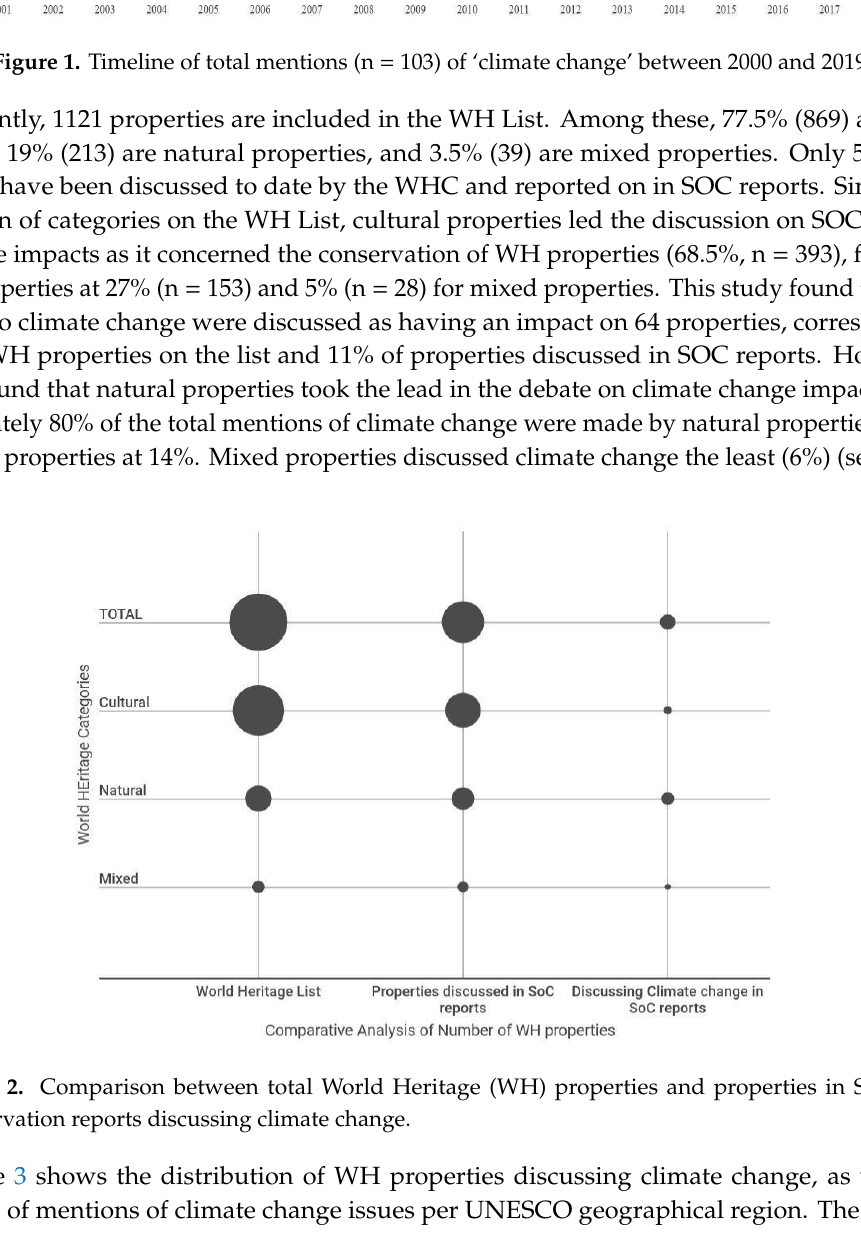
Figure 1. Timeline of total mentions (n = 103) of ‘climate change’ between 2000 and 2019.